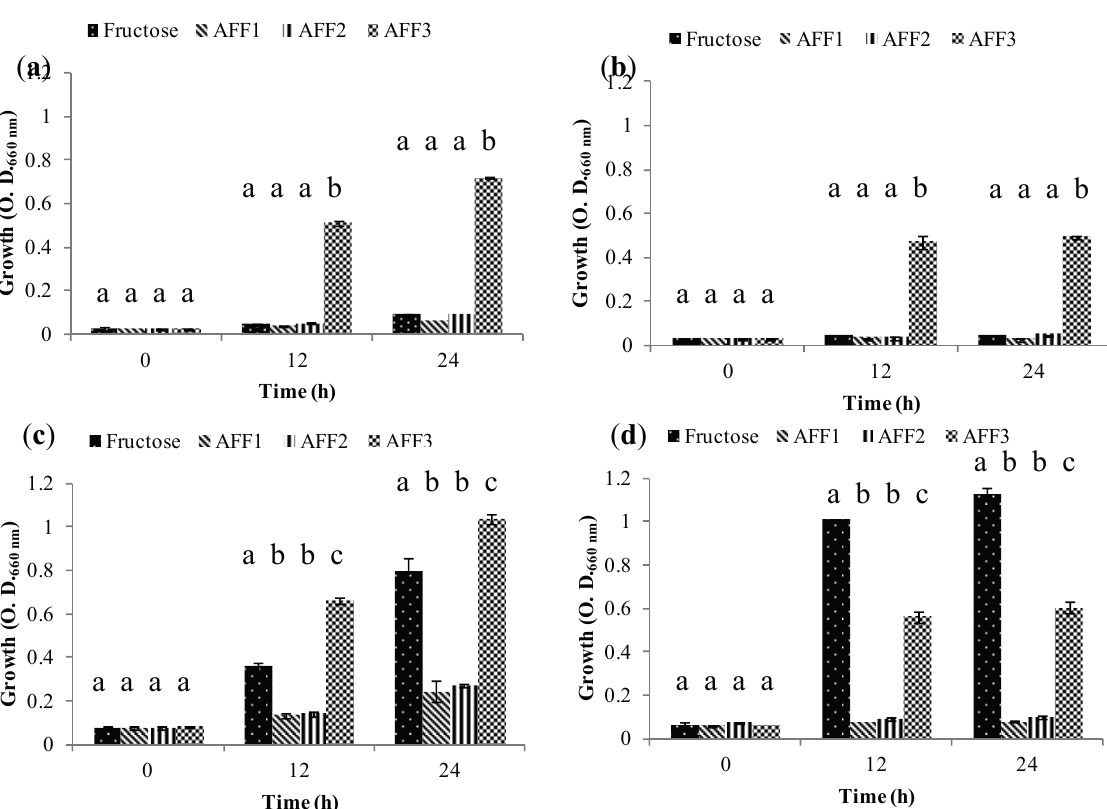
Figure 5. Growth (O.D.) of probiotic bacteria in Group 2 (G2) at 0, 12 and 24 h in semi-synthetic medium using AFF1, AFF2, AFF3 as the sole carbon source and fructose as fermentation control. ( a ) Bifidobacterium lactis DSM 10140. ( b ) Bifidobacterium animalis ATCC 25527. ( c ) Bifidobacterium longum ATCC 15707. ( d ) Bifidobacterium breve ATCC